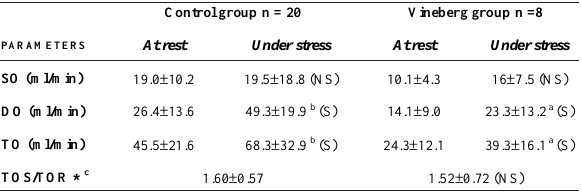
Table 1. Analysis of the flow parameters in the left internal thoracic artery obtained by echocardiography at rest and under stress of group A (control group) and group B (Vineberg group).